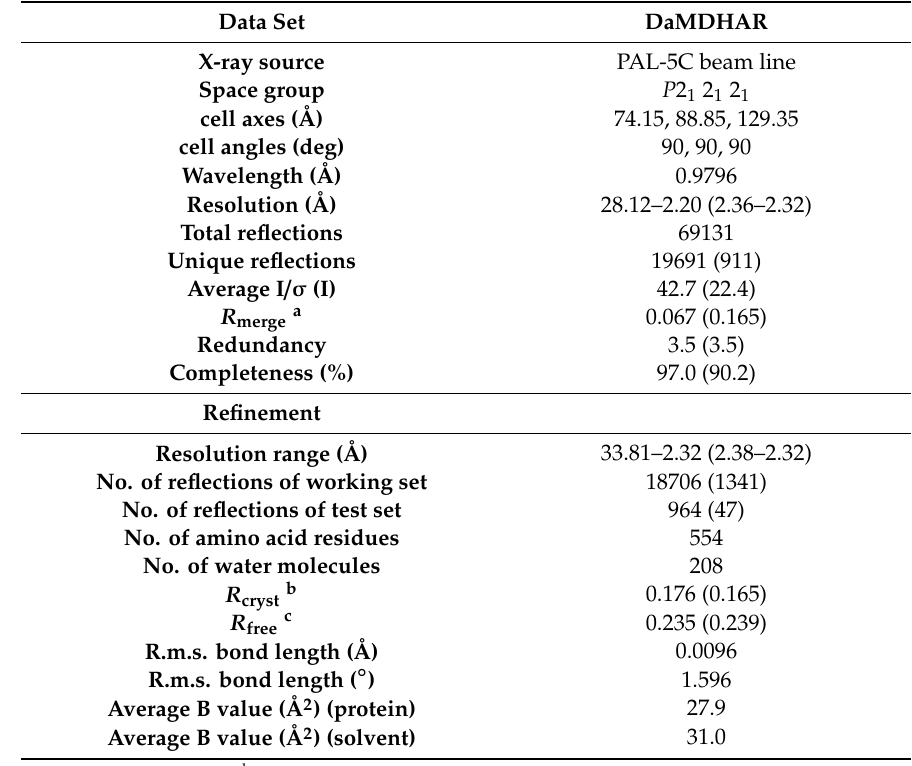
Table 1. X-ray di ff raction data collection and refinement